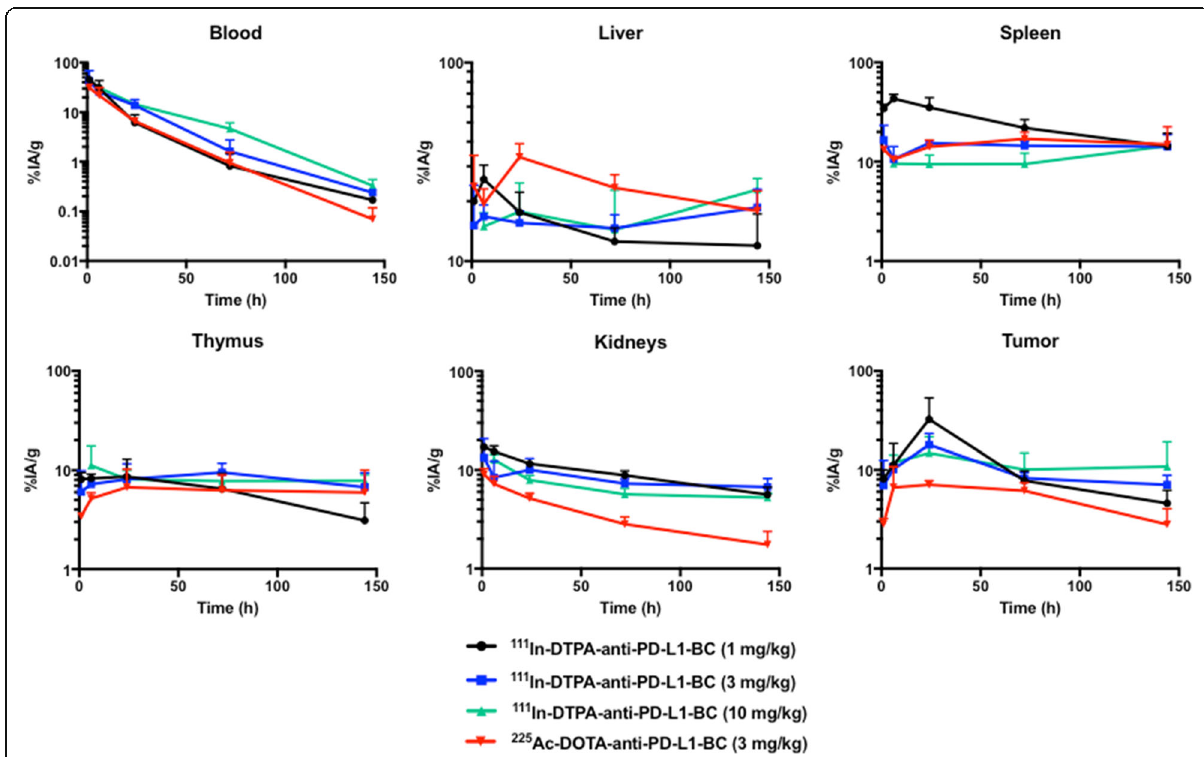
Fig. 1 Clearance profiles of select organs: Blood, liver, spleen, thymus, kidneys, and tumor (note that the y -axis is presented on a logarithmic scale)